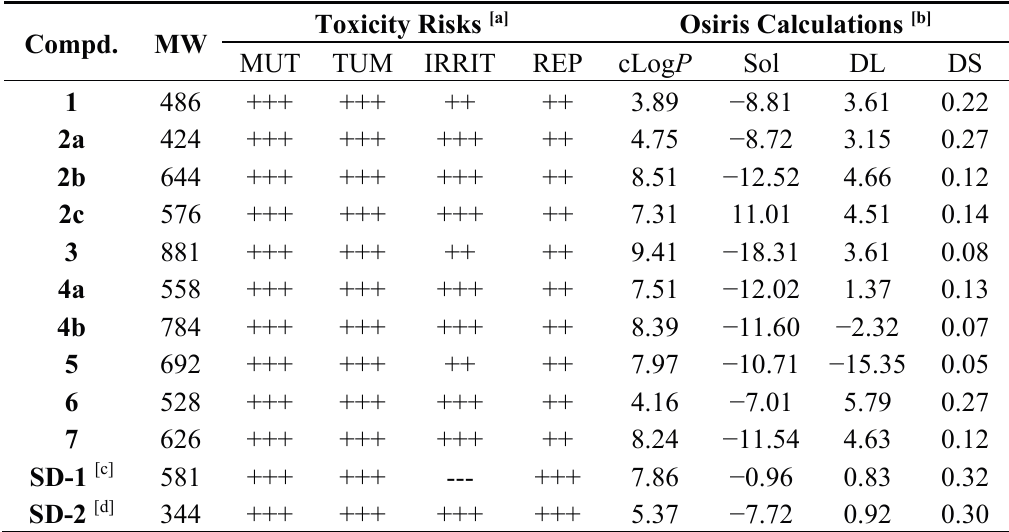
Table 2. Osiris calculations of toxicity risks of compounds 1 – 7